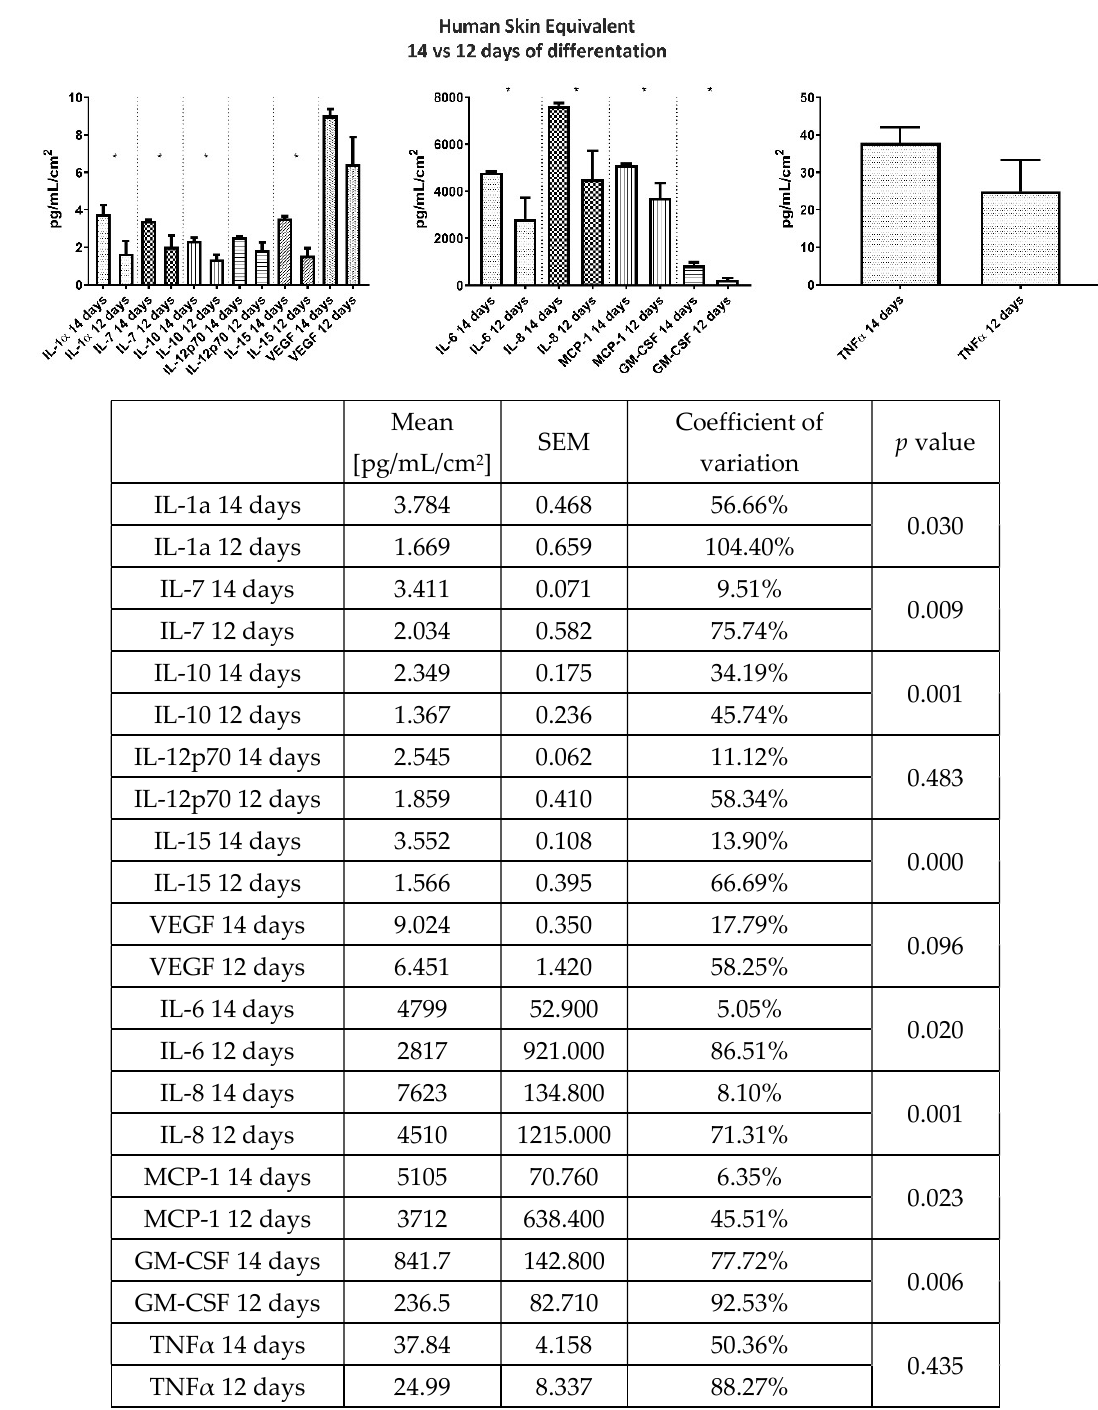
Figure 4. Comparison of GM-CSF (granulocyte-macrophage colony-stimulating factor), IL-10, IL-12p70, IL-15, IL-1α, IL-6, IL-7, IL-8, (interleukins), MCP-1 (monocyte chemoattractant protein-1), TNFα (tumor necrosis factor α), and VEGF (vascular endothelial growth factor) levels in 24 h culture supernatant between 12 and 14 days differentiated HSEs. Results presented as Mean ± SEM [pg/mL/cm 2 ]. The variability between the samples is measured by the coefficient of variation.